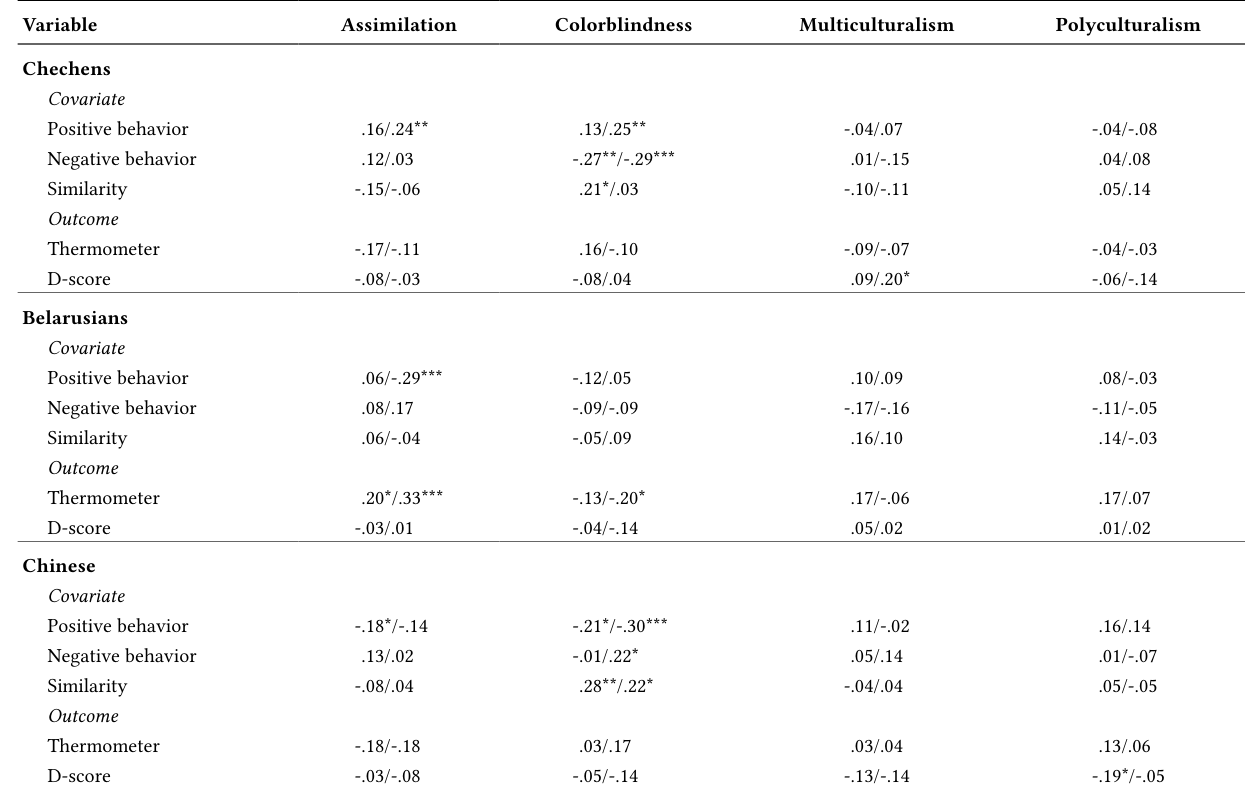
Bivariate and Partial Correlations between Diversity Ideologies and Intergroup Bias in Study 2 (N =